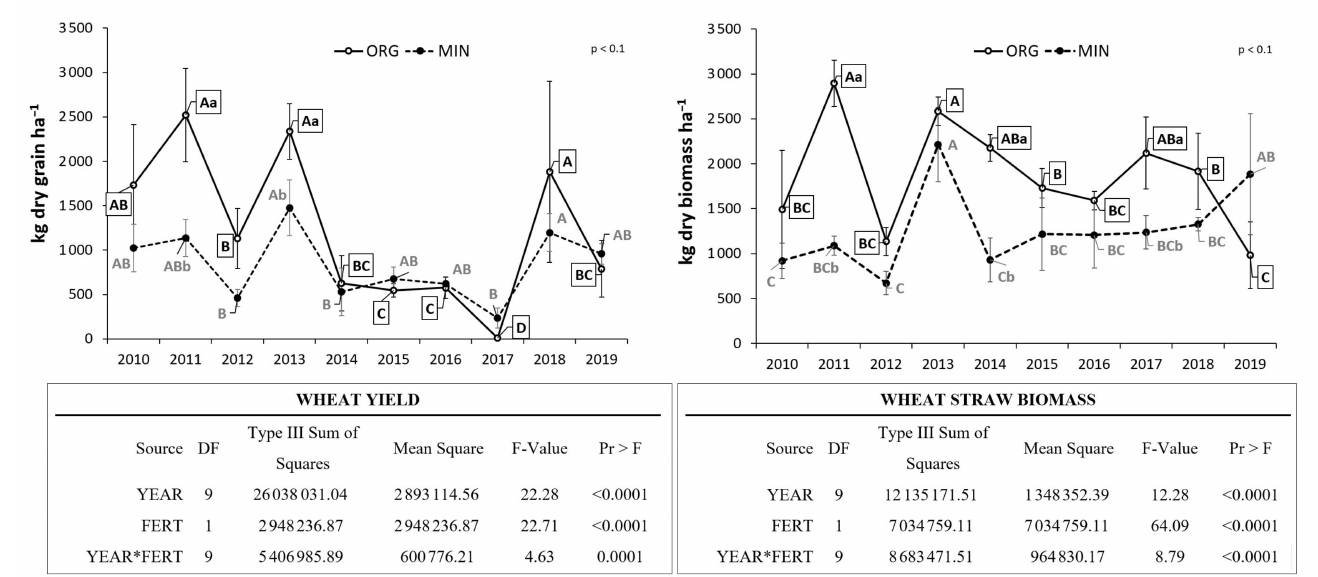
Figure 2. Wheat grain yield and straw biomass production (kg dry matter ha − 1 ) under the differentiated management practices (ORG vs. MIN) since the beginning of the experimental trial. Bars indicate the standard deviation of the data. Means followed by uppercase different letters are significantly different among years and those followed by lowercase letters are different between ORG and MIN treatments for the same year for either yield or straw biomass ( p < 0.1). Type III analysis of variance (PROC GLM) for evaluating YEAR and fertilization (FERT) influences on wheat yield and biomass. “DF” is the degrees of